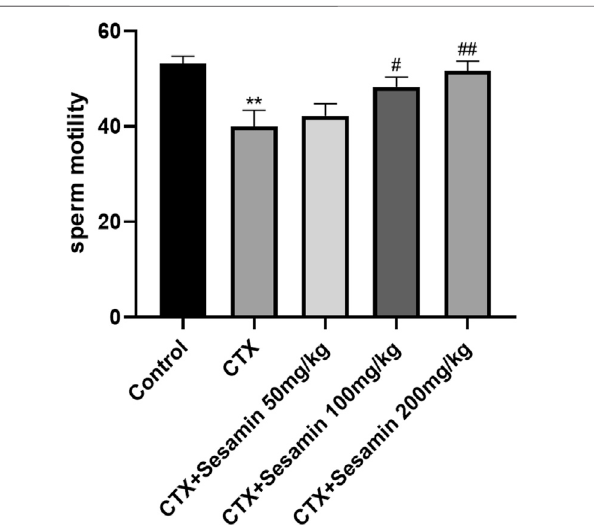
FIGURE 1 | Sesamin attenuates sperm counts induced by CTX exposure in ICR mice. The results are presented as mean ± SEM (n (cid:2) 10). * p < 0.05, ** p < 0.01, and *** p < 0.001 as compared with the control group; # p < 0.05 and ## p < 0.01 as compared with the CTX group.